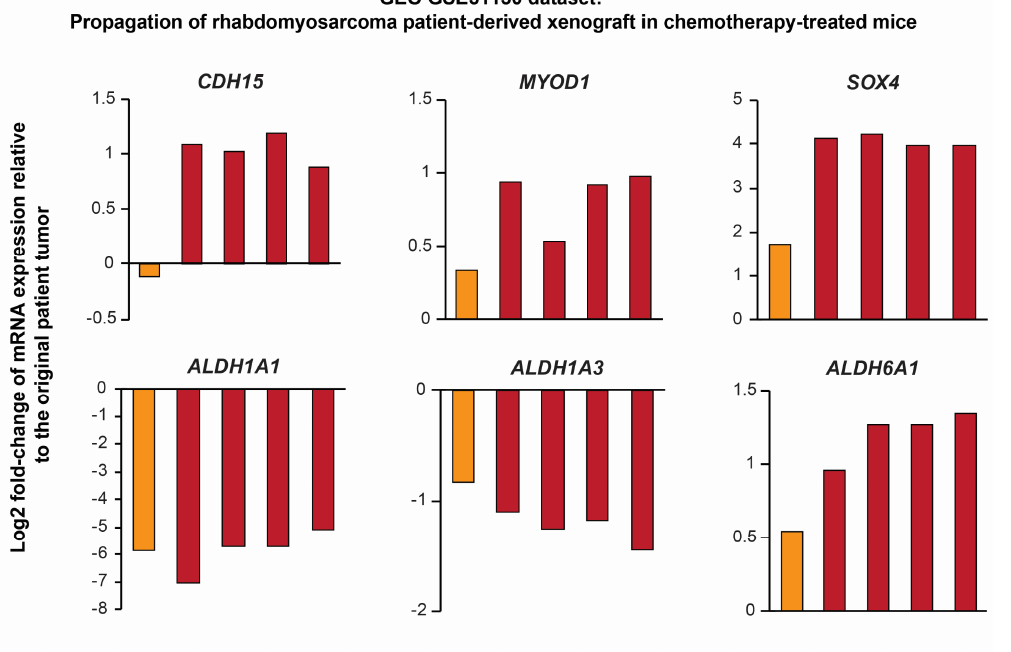
Figure 7. Gene expression profiles of aggressive chemotherapy-resistant rhabdomyosarcoma patient-derived xenografts (Gene Expression Omnibus (GEO) GSE51130 dataset) resemble the stemness-associated gene expression signature identified using our approach. Note the marked downregulation of ALDH1A1 and upregulation of ALDH6A1 in refractory chemoresistant xenografts (red bars; expression for individual biological replicates) compared with the original patient tumor.